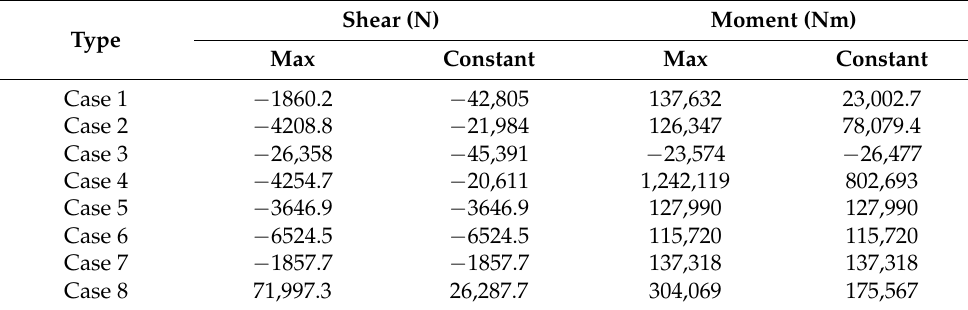
Table 4. Result force story 6 for element 123.